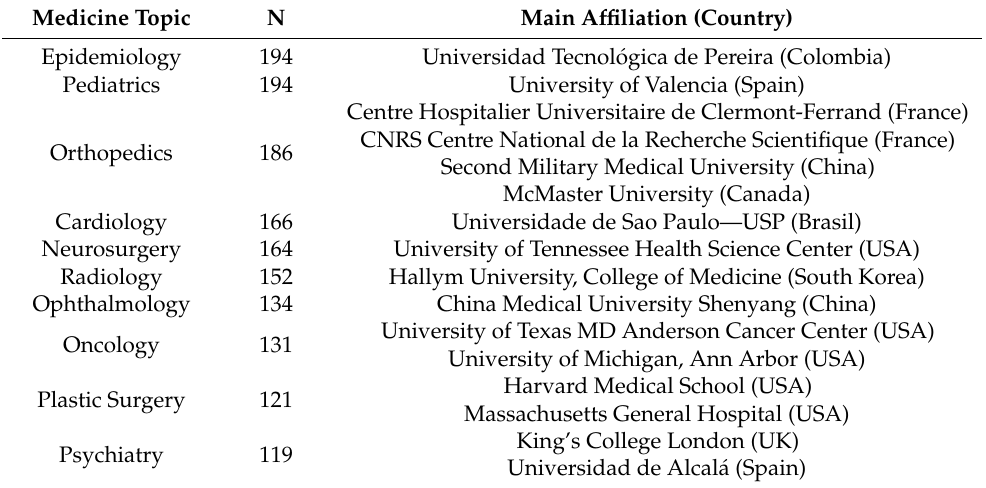
Table 12. Top 10 medical keywords in bibliometric publications in this category and the main affiliations using